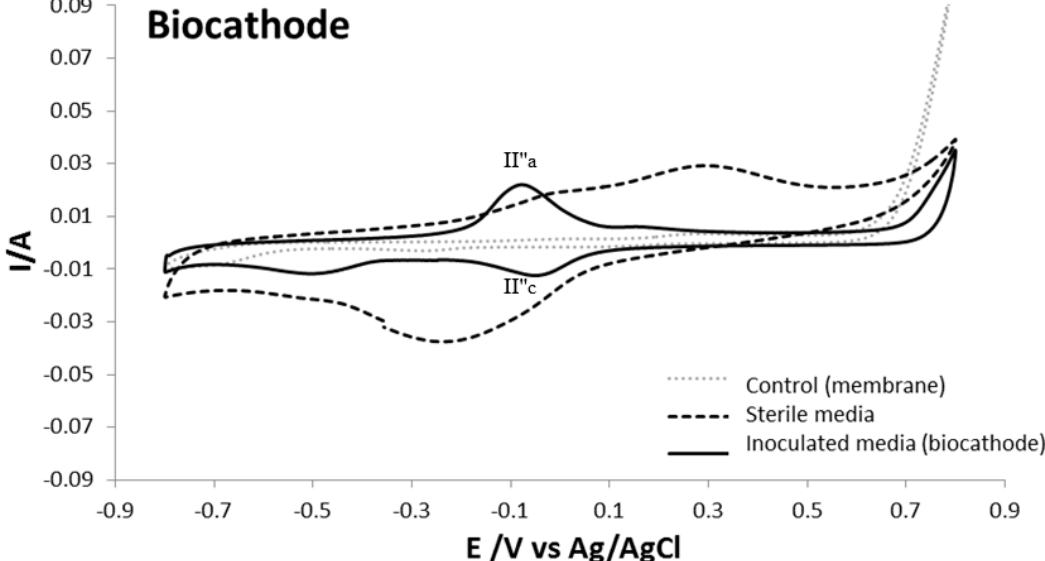
Figure 4. In situ cyclic voltammograms of the MFC cathodic chamber (using the MFC cathode as working electrode); non-sterile media (inoculated media) comparison with the controls, namely, sterile media (abiotic cathode) and the use of membranes to hinder biofilms presence; potential window: − 0.8 to +0.8 V; scan rate 20 × 10 − 3 V s − 1 .